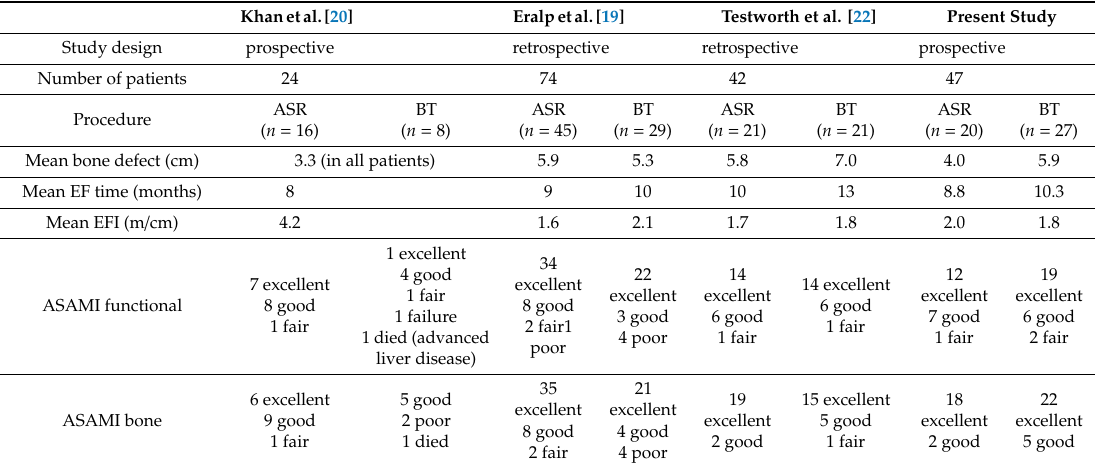
Table 4. Results of comparative trials in the